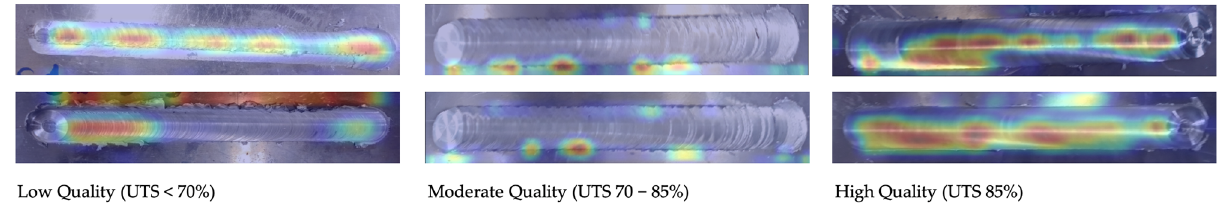
Figure 12. GradCam images of the three classes of the classification model.